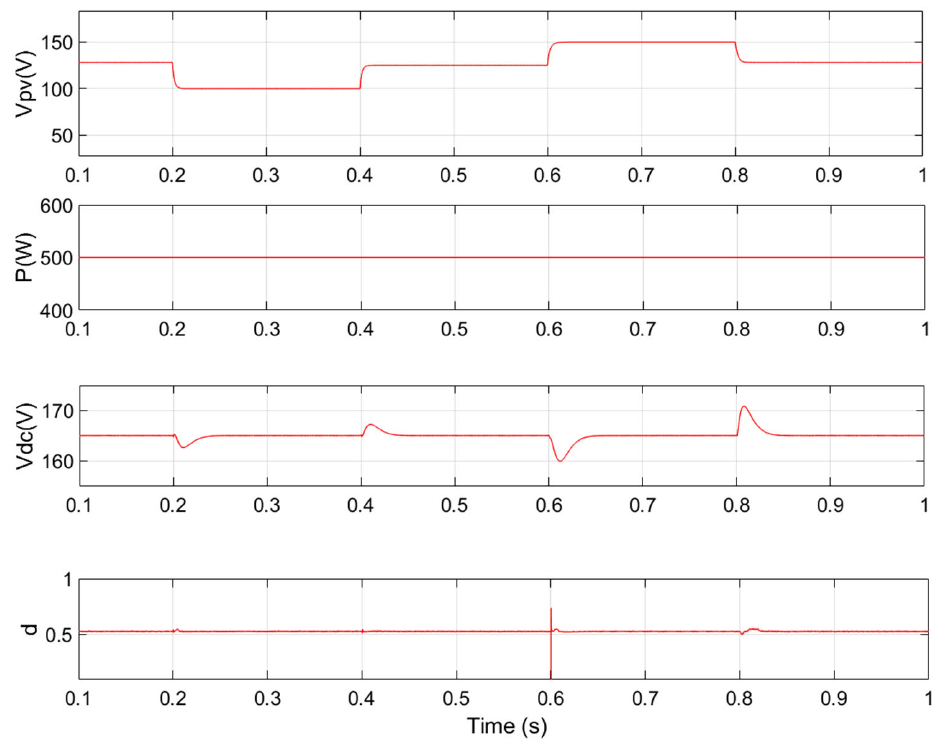
Figure 7. Simulation results under PV voltage variation and fixed CPL.